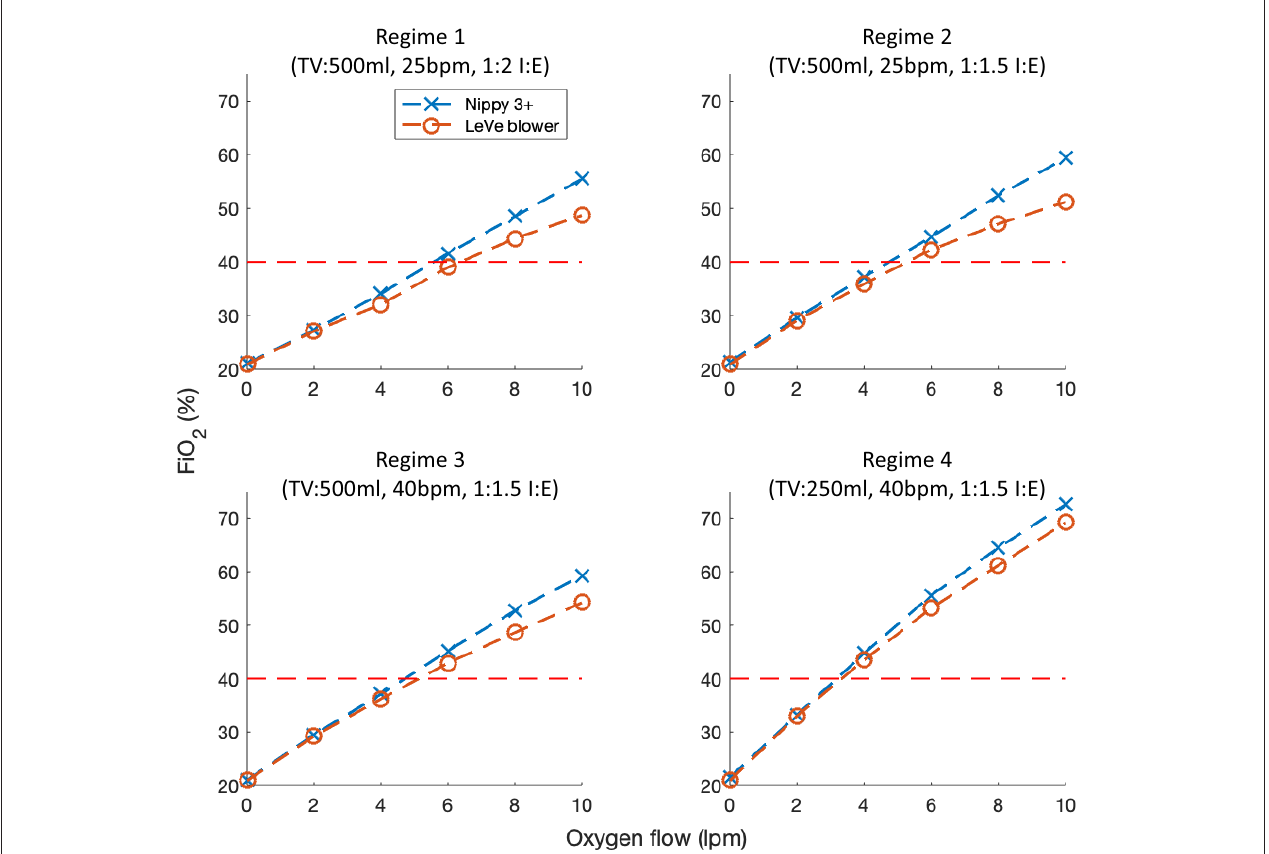
FIGURE 7 | FiO 2 characteristics of the LeVe breathing circuit in comparison to a sleep apnea CPAP system (Nippy 3 + ) under different respiratory regimes defined by Tidal Volume (TV), Breaths per Minute (BPM), and Inspiration:Expiration ratio (I:E). Oxygen flow rates reported under NTP.